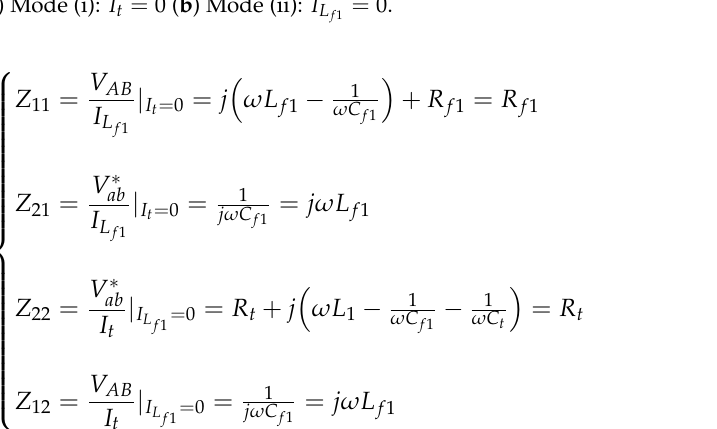
Figure 5. ( a ) Mode (i): I t = 0 ( b ) Mode (ii): I L